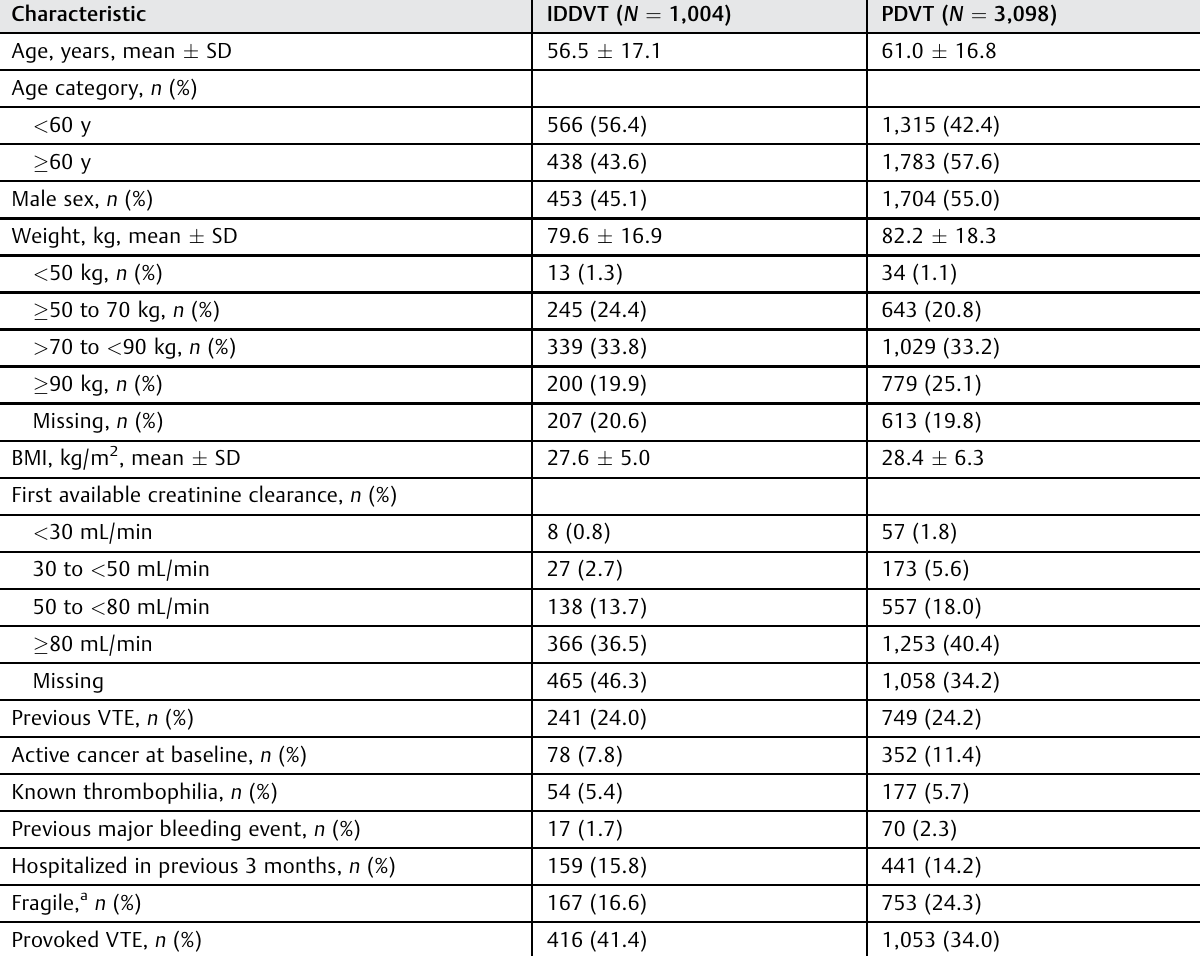
Table 1 Baseline demographics and clinical characteristics of patients with IDDVT and PDVT in the safety analysis set